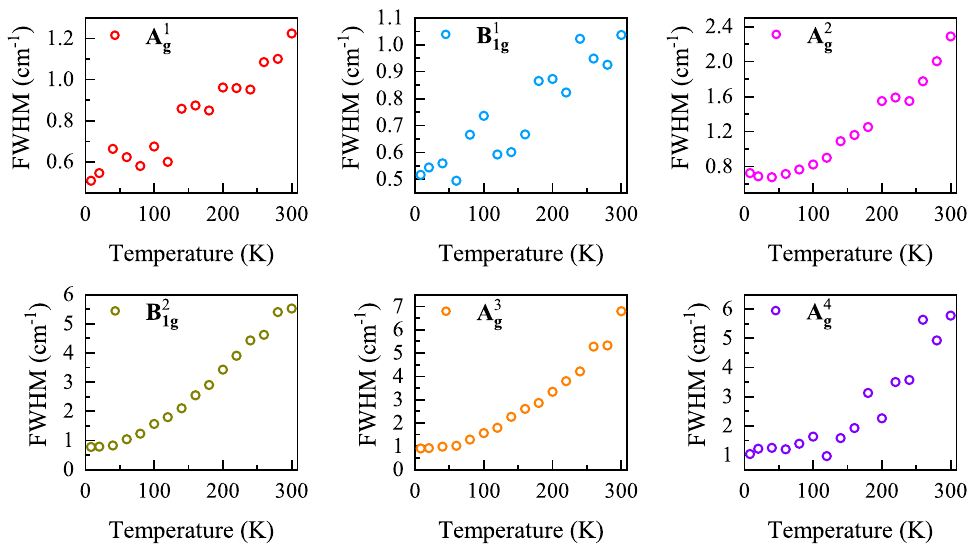
Figure A3. Temperature evolution of the FWHMs for the all observed phonon